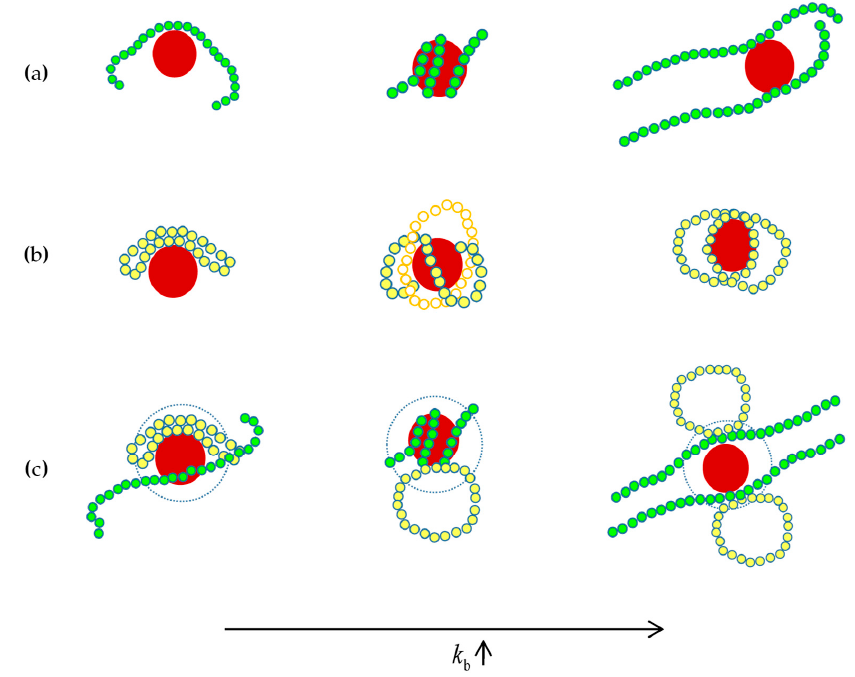
Figure 7. Schematic diagram of nanocomposites conformation at a strong attraction: ( a ) linear chain, ( b ) ring chain, ( c ) mixture of linear chain and ring chain. ( b ) ring chain, ( c ) mixture of linear chain and ring